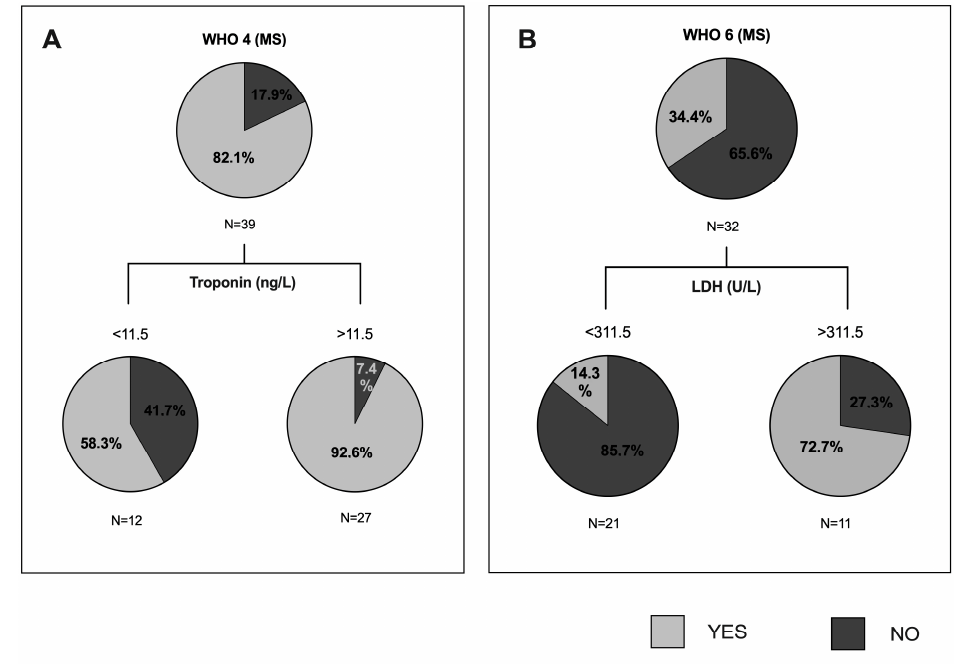
Figure 3. Classification and regression trees of the cohort with metabolic syndrome were elabo- rated through CRT method for WHO 4 and WHO 6 variables of severe pneumonia by COVID-19, namely: (4) oxygen by mask or nasal; (6) intubation with mechanical ventilation (MV), mask with reservoir. ( A ) Pie charts represent the proportion of patients with MS who met the WHO 4 (light grey) or not (dark grey) at each node of the tree. MS: metabolic syndrome. ( B ) Pie charts represent the proportion of patients who met the WHO 6. MS: metabolic syndrome; LDH: lactate dehydro- genase.